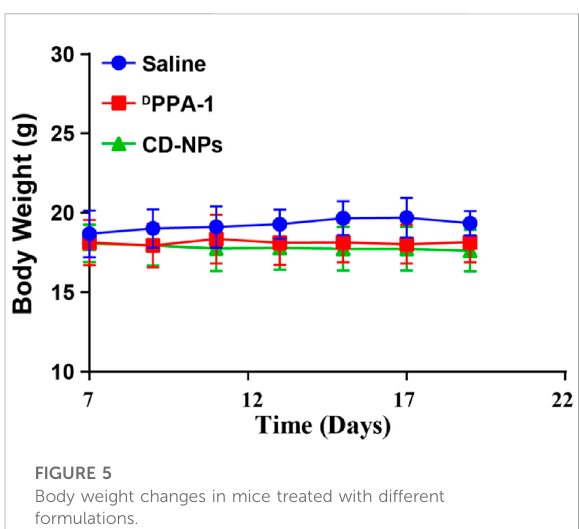
Body weight changes in mice treated with different